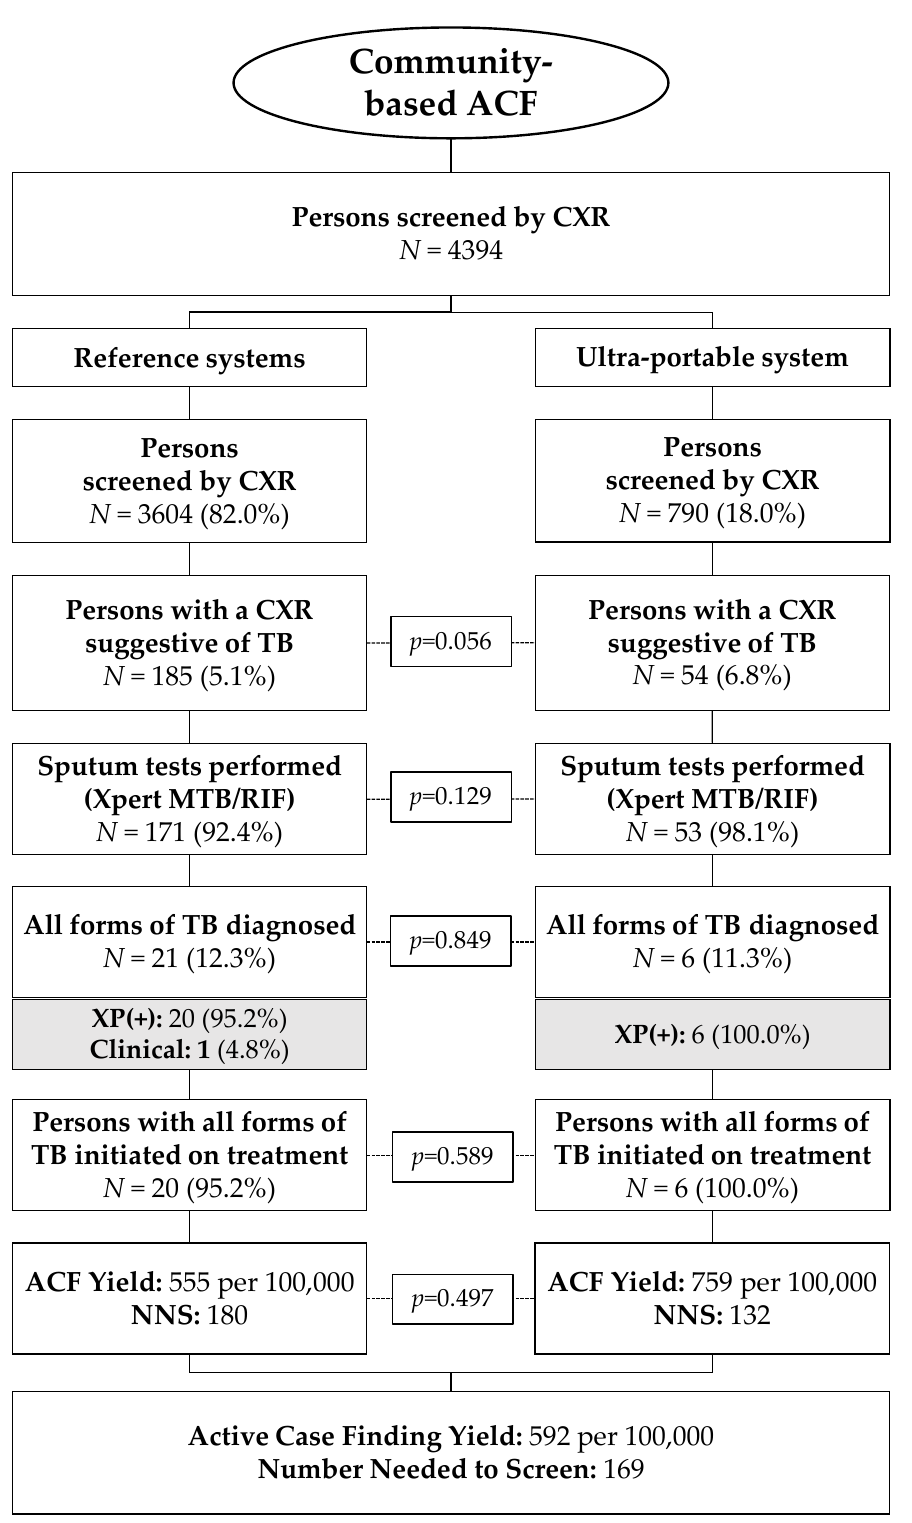
Figure 2. TB care cascade disaggregated by X-ray system used during the community screening events.